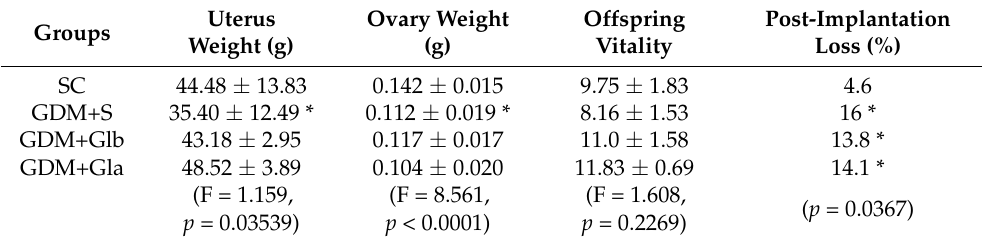
Table 1. Reproductive Capacity of GDM-STZ rats treated with Ganoderma lucidum . Groups